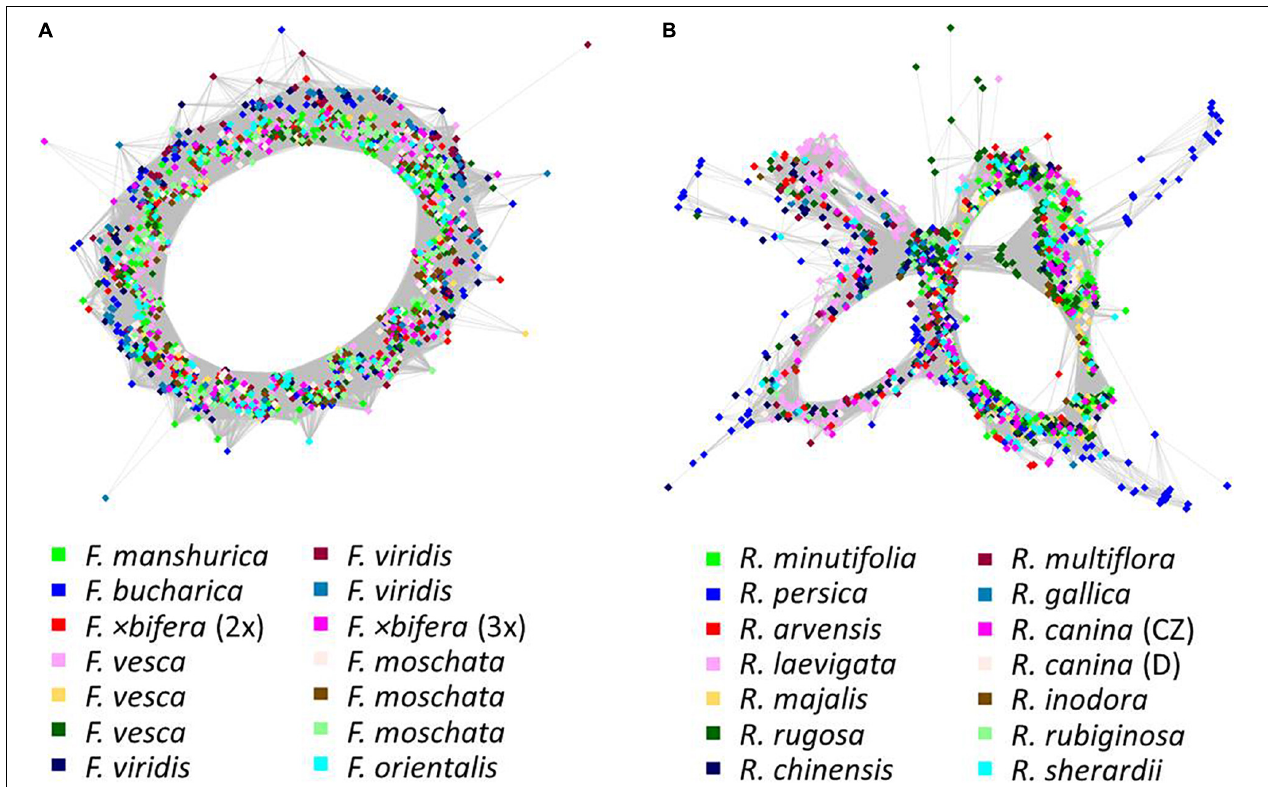
FIGURE 6 | Graph shapes of 5S rDNA clusters from RepeatExplorer2 comparative clustering. Colors indicate (A) Fragaria and (B) Rosa species. Nodes represent reads, and their similarities are expressed as edges. The general graph shape depends on the repeat motif and its